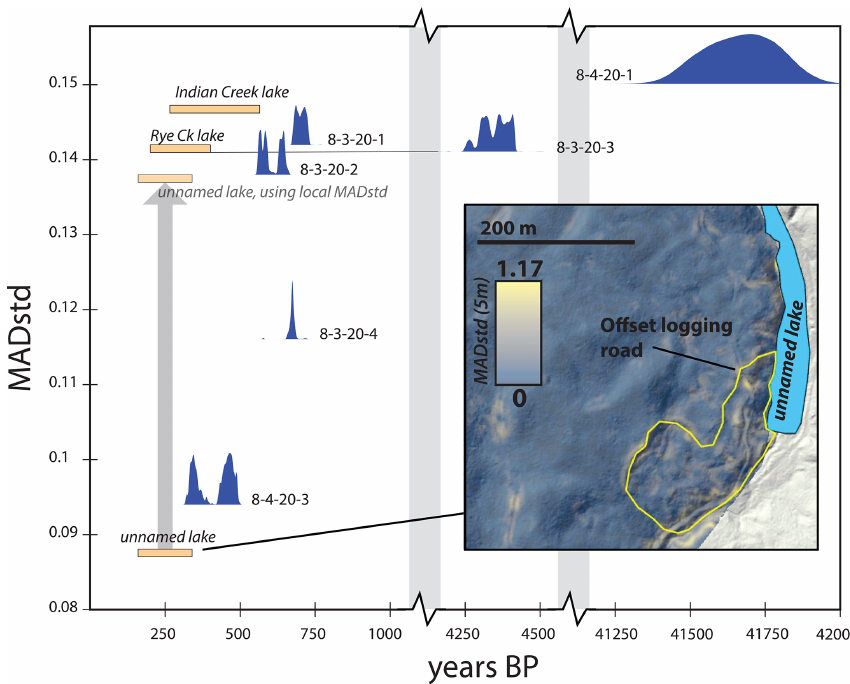
Figure 5. Comparison of maximum age estimates and MADstd values. Range of maximum earthflow ages from lake sedimentation are shown as orange bars and radiocarbon ages are shown with blue probability distribution functions. Inset shows the MADstd values calculated with a 5m moving window for the earthflow complex creating the unnamed lake. Note the relatively low MADstd in blue despite dense Pinus ponderosa forest covering the earthflow surface. Yellow outline shows a possible re-activation of part of the complex, which raises the MADstd associated with lake formation from 0.087 to 0.137.